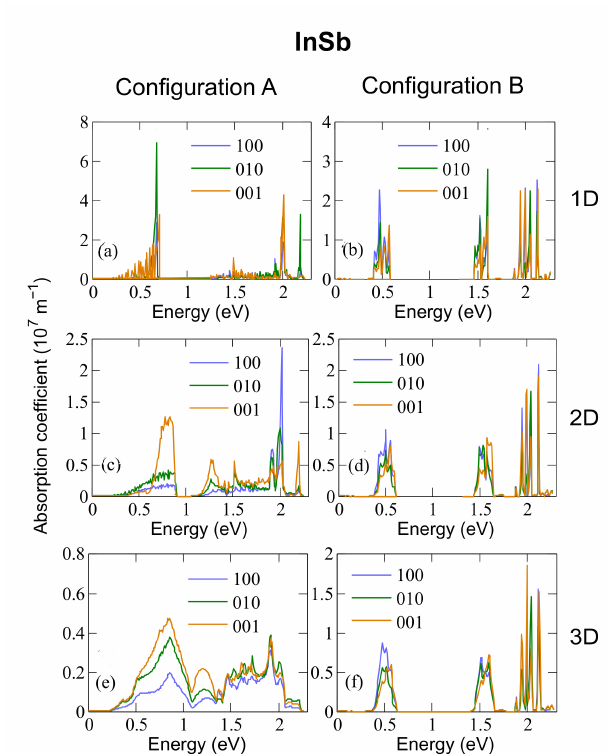
Figure 7. Absorption coefficient calculated at 300 K for 1D ( a , b ), 2D ( c , d ) and 3D ( e , f ) arrays of InSb dots with radius R = 13.1 Å and either anion-rich (configuration A, left panels) or cation-rich (configuration B, right panels) surfaces.